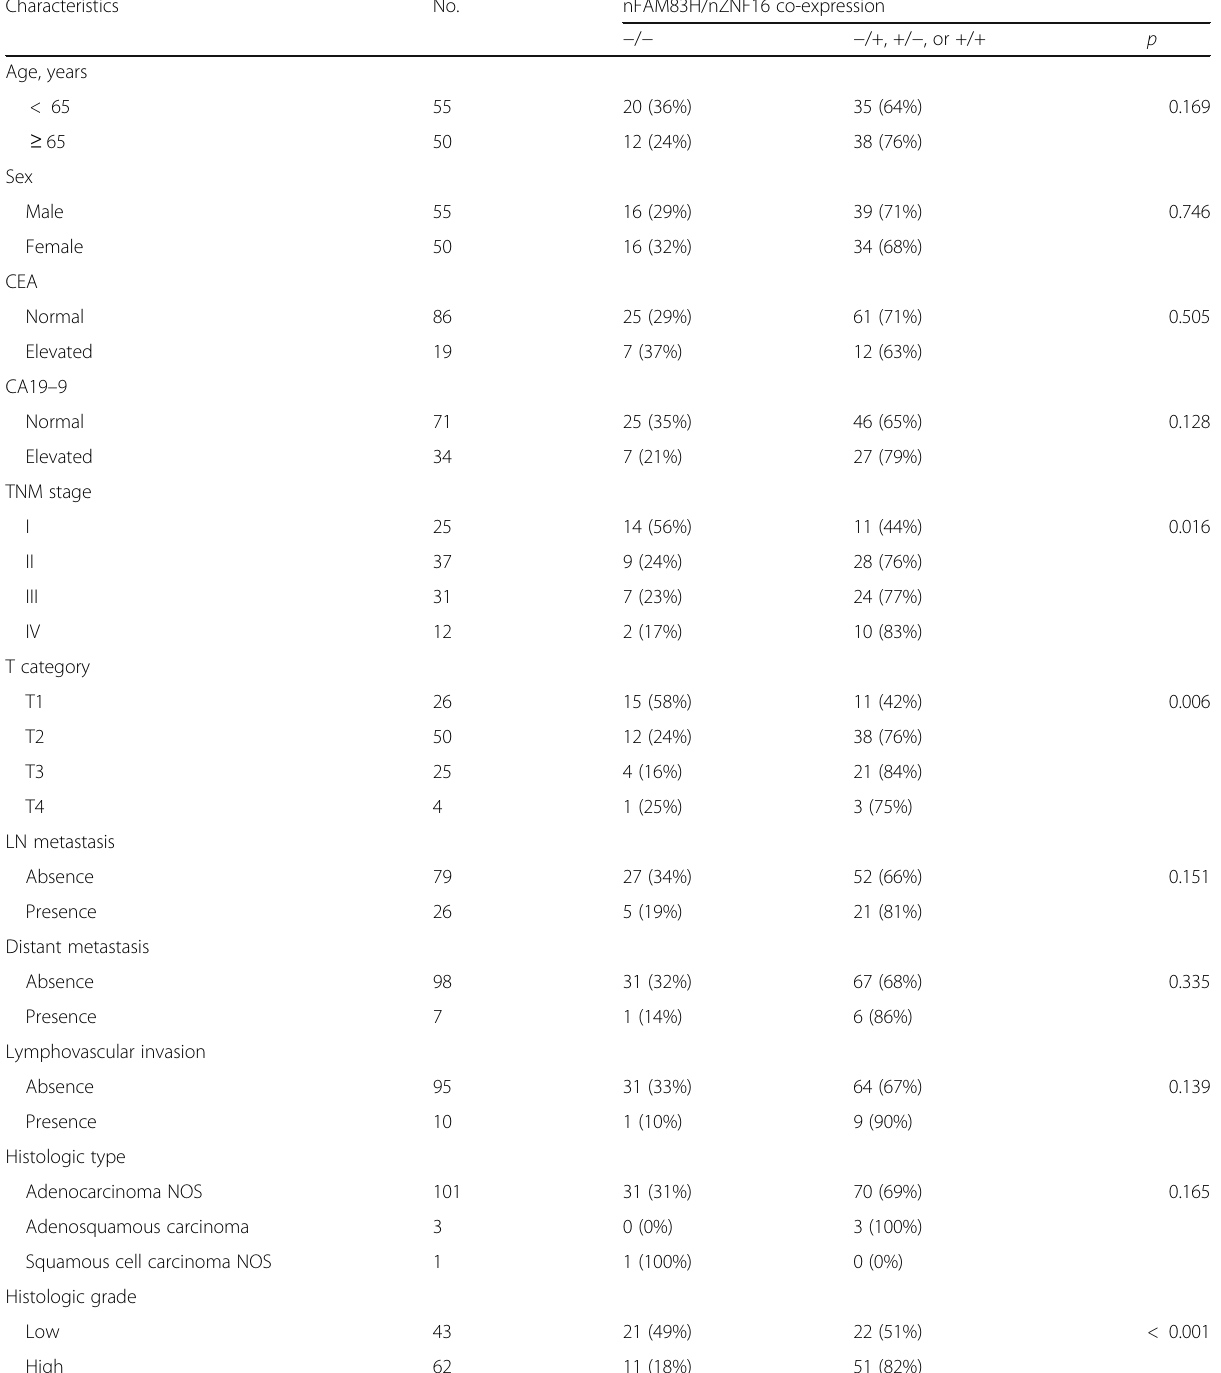
Table 5 Clinicopathologic variables and co-expression patterns of nuclear FAM83H and nuclear ZNF16 in gallbladder carcinomas